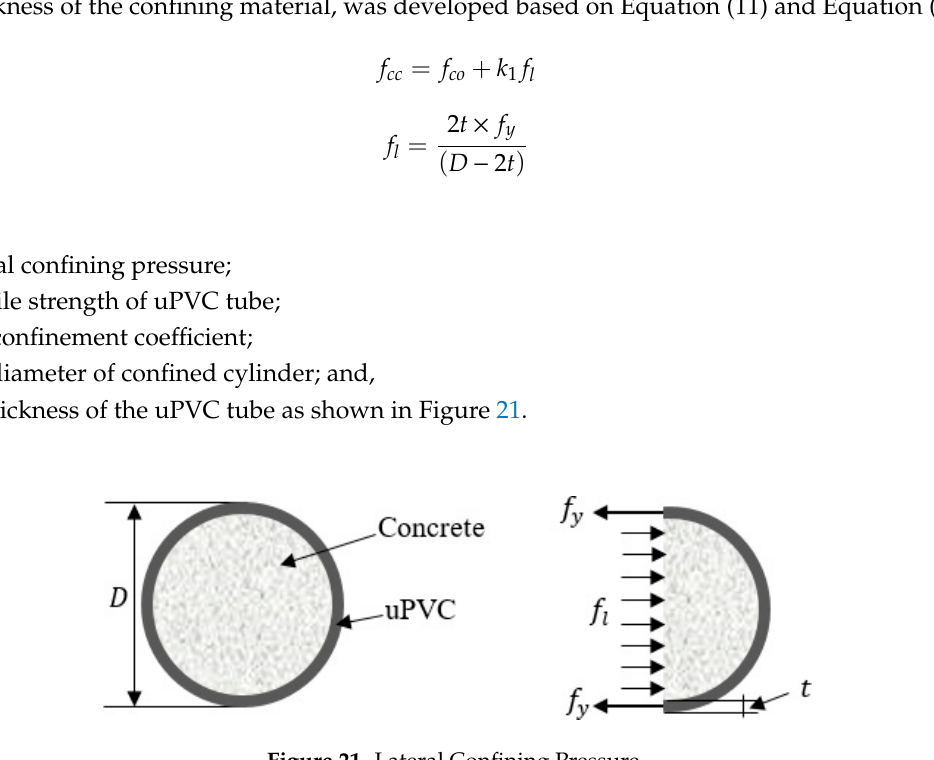
Figure 21. Lateral Confining Pressure.